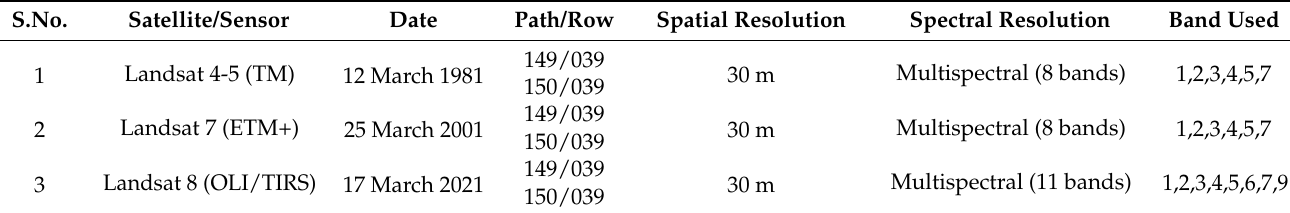
Table 1. Specification of Landsat satellite data was used in this